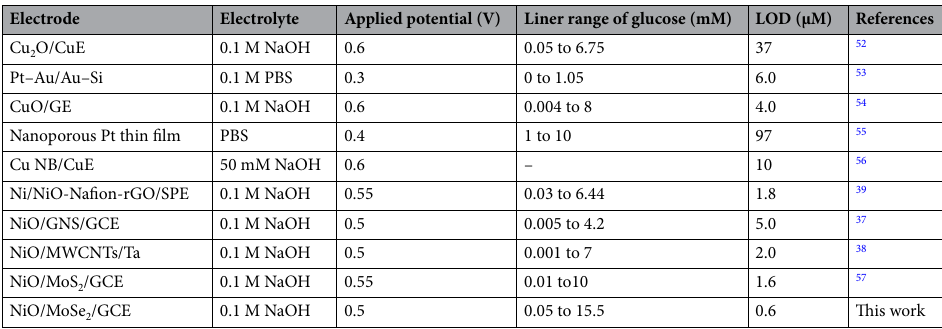
Table 1. Comparison of the analytical performance of the NiO/MoSe 2 electrode with the other reported glucose sensors based on different electrode materials. NB nanobelt, NiO/GNS nickel oxide/graphene nanosheet, MWCNTs multi-walled carbon nanotubes, CuE Copper electrode, Au–Si gold coated silicon substrate, GE graphite electrode, GCE glassy carbon electrode, SPE screen printed electrode, PBS phosphate buffer solution, Ta Tantalum.